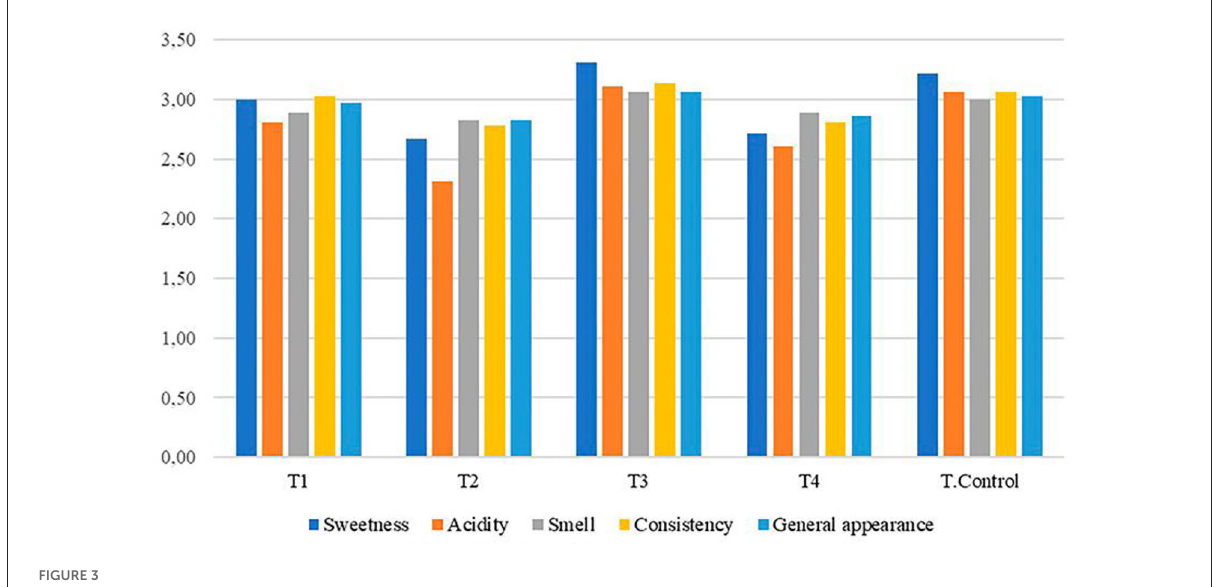
FIGURE3 Sensorial preferences of yogurt